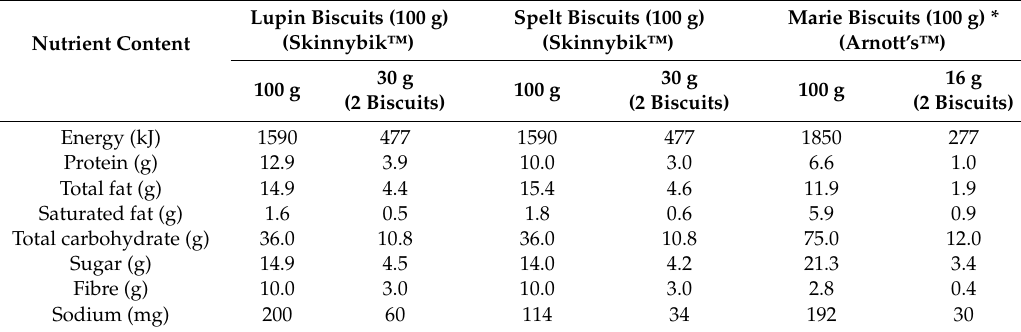
Table 1. Nutrient composition of lupin, spelt and standard hospital mid-meal